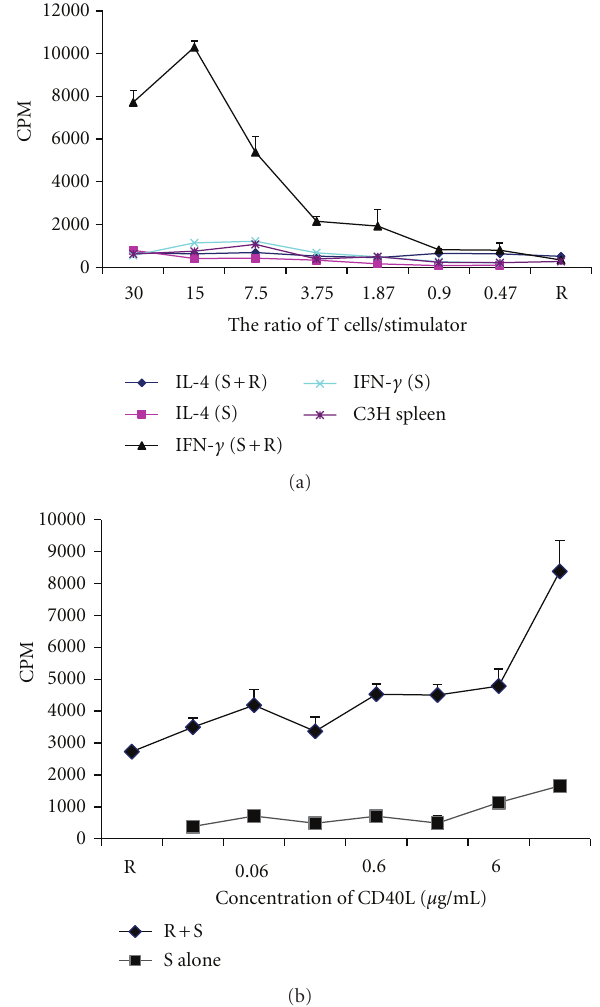
Figure 4: The ability of cytokine-treated MTHCs to stimulate mixed lymphocyte reaction (MLR). (a) The MLR results with MTHCs cotreated with 200 unit/mL TNF- α and IL-4 or IFN- γ as stimulator ( S ) and enriched T cells from C57BL/6 mouse spleen as responders ( R ). Stimulators and responders were set up at di ff erent ratios as indicated. (b) The e ff ect of CD40L treatment on MLR: different doses of CD40L were added to MLR with IFN- γ + TNF- α - treated MHTCs as stimulators and enriched C57BL/6 spleen T cells as responders (at the ratio of 3.75). The data were the mean ± SE of three separate experiments.